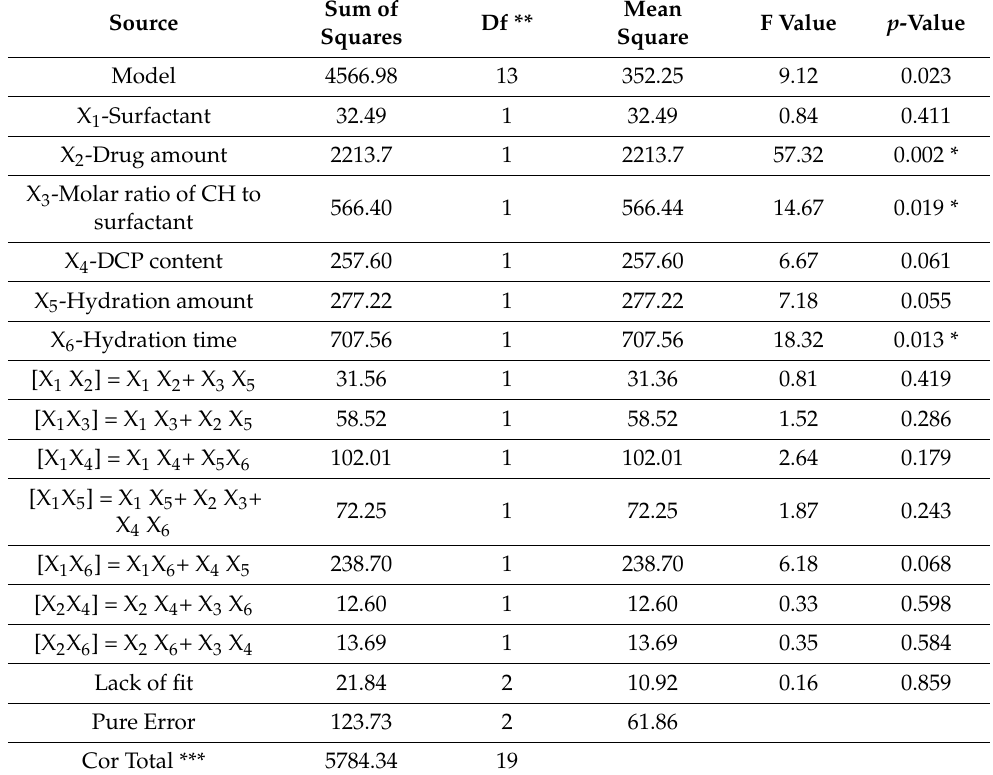
Table 5. Summary of analysis of variance (ANOVA) for the 2 (6 − 2) factorial design for EGCG-niosome variable